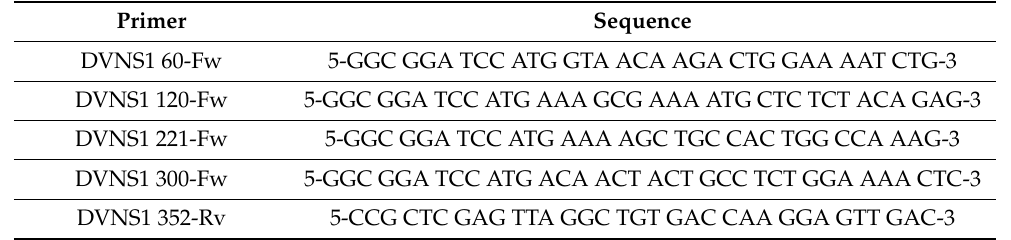
Table 2. Primers for the construction of cDNA